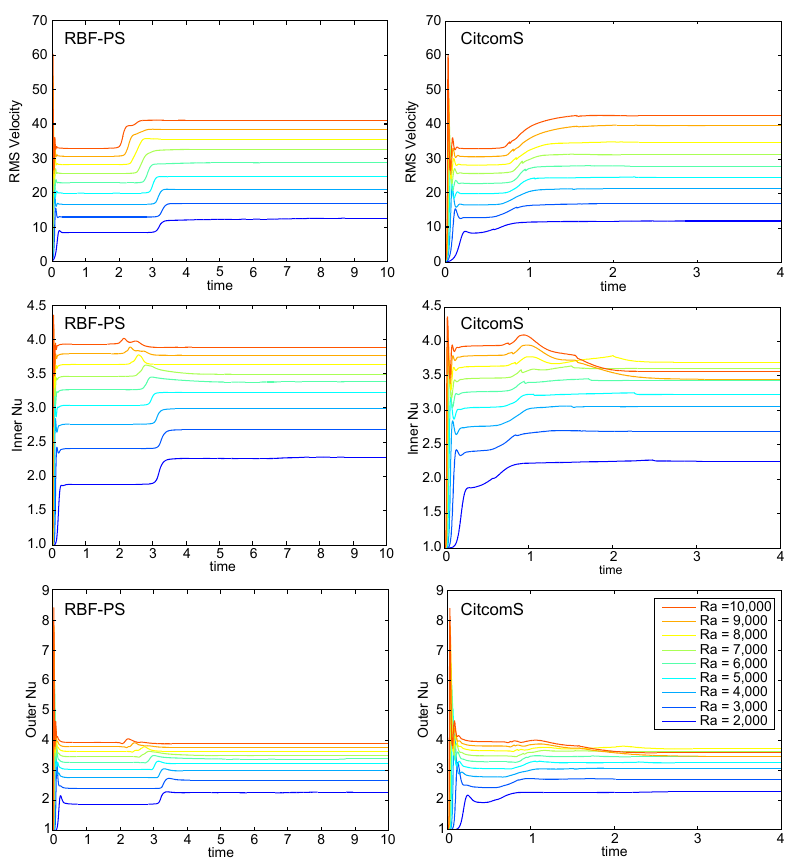
Figure 9. Transition between steady states, as evidenced by both the RBF-PS and CitComS models, in the h V rms i (top panels), Nu i (middle panels), and Nu o (bottom panels) for the dodecahedral initial condition. Table 1. Comparison between computational methods RBF and CitcomS for the dodecahedral stationary pattern at various Rayleigh number. For CitcomS and a Ra = 2000, the dodecahedral pattern does not satisfy stationarity to estimate parameters